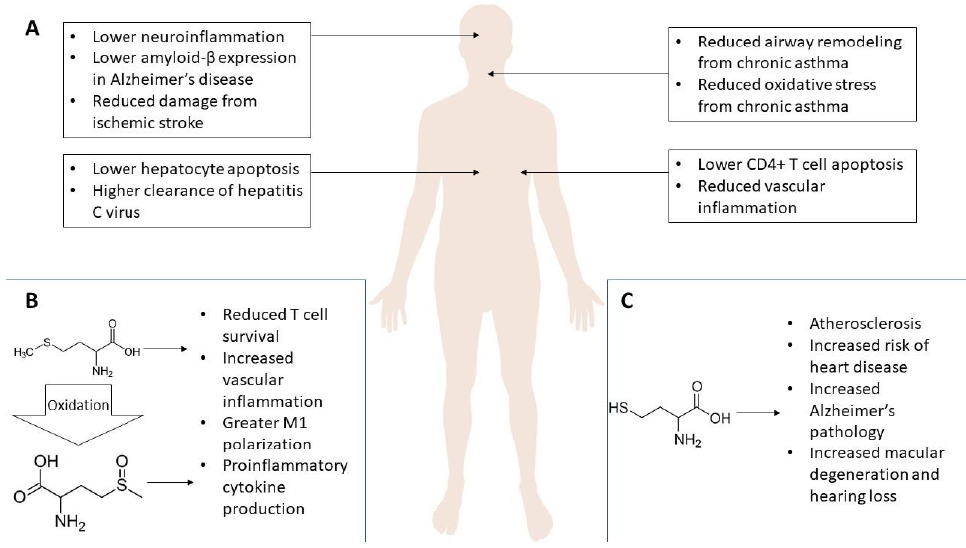
Figure 3. SAM and inflammation. Overview of the effects of SAM supplementation on the brain ( top left ), airways ( top right ), liver ( bottom left ), and spleen/vasculature ( bottom right ) ( A ). Possi- ble model of the pathology of hypermethionemia, typically caused by defects in MAT preventing hepatic processing to SAM. Accumulation of methionine in the cell leads to incidental oxidation to methionine sulfoxide, necessitating enzymatic reversal ( B ). Summary of the effects of hyperhomo- cysteinemia on disease pathology ( C ).